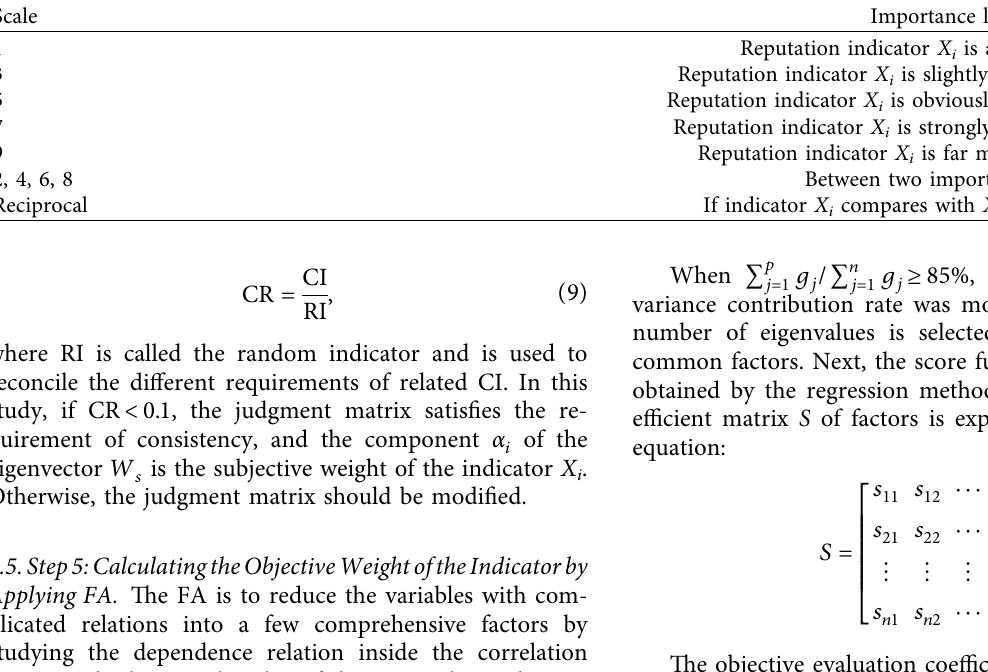
ij with a scale of